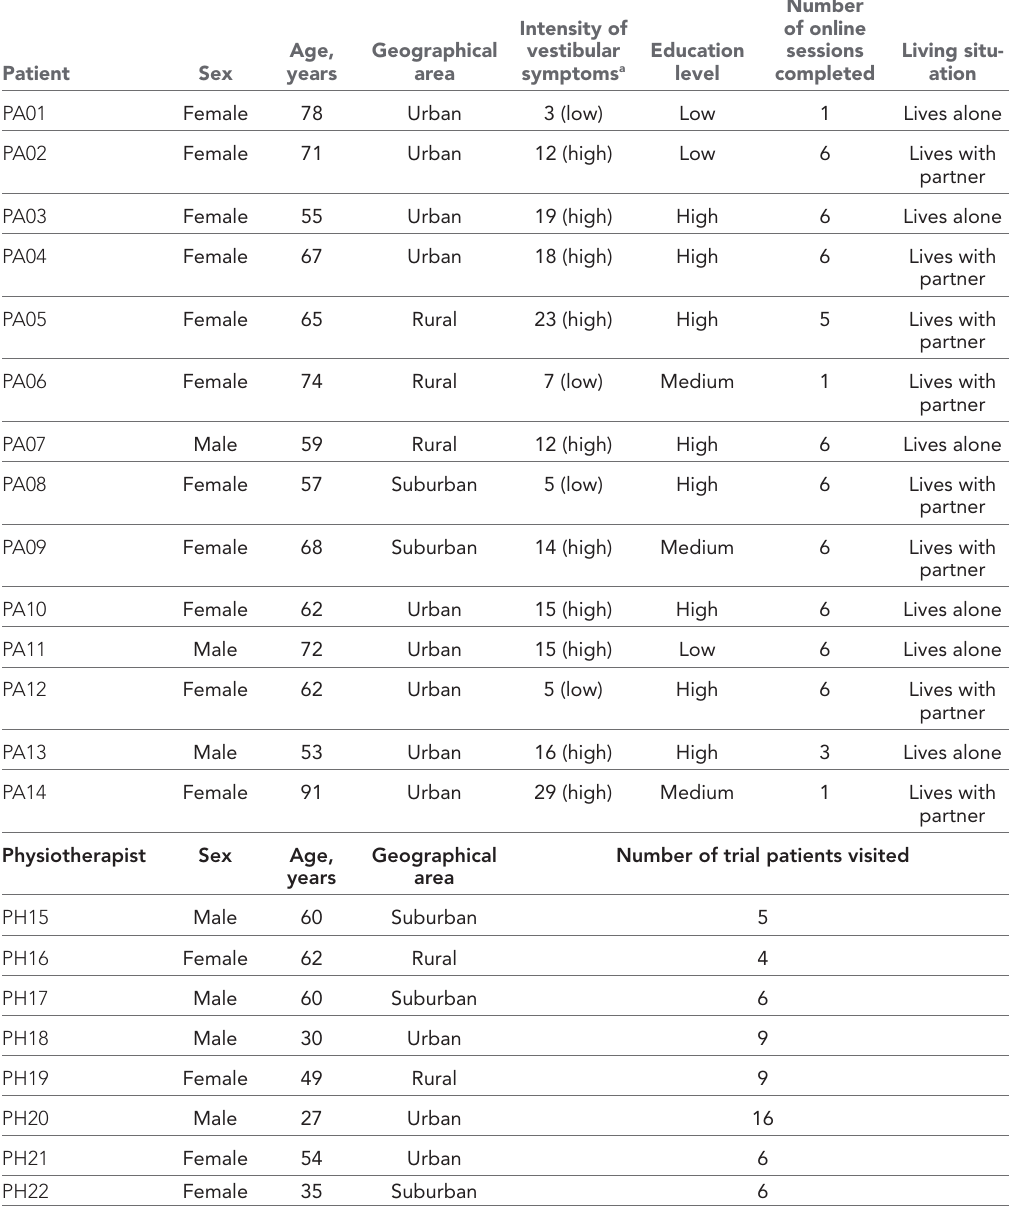
Table 1 Characteristics of patients and physiotherapists who were interviewed